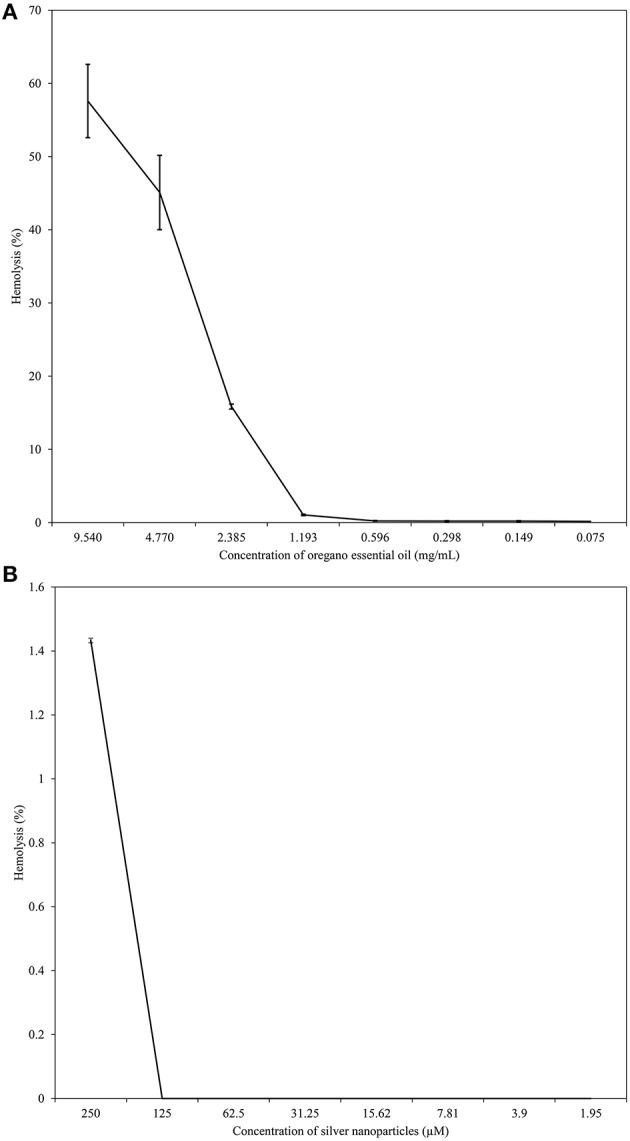
Hemolytic activity of different concentrations of OEO and bio-AgNP individually. (A) Human erythrocytes exposed to OEO alone ranging from 0.075 to 9.540 mg/mL. (B) Human erythrocytes exposed to bio-AgNP ranging from 1.95 to 250 μM. Values of hemolysis percentage are the mean ± standard deviation.